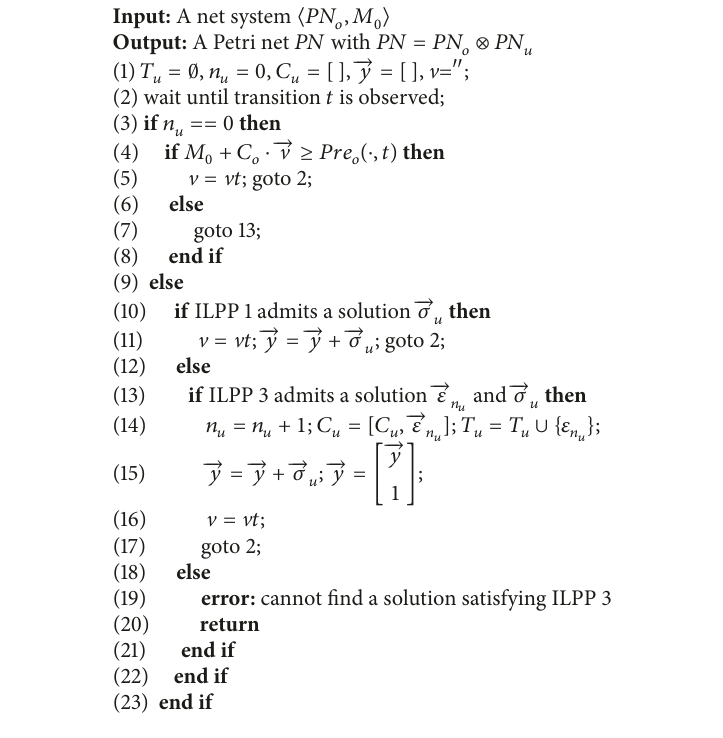
Algorithm 1: Identification of an unobservable subnet.